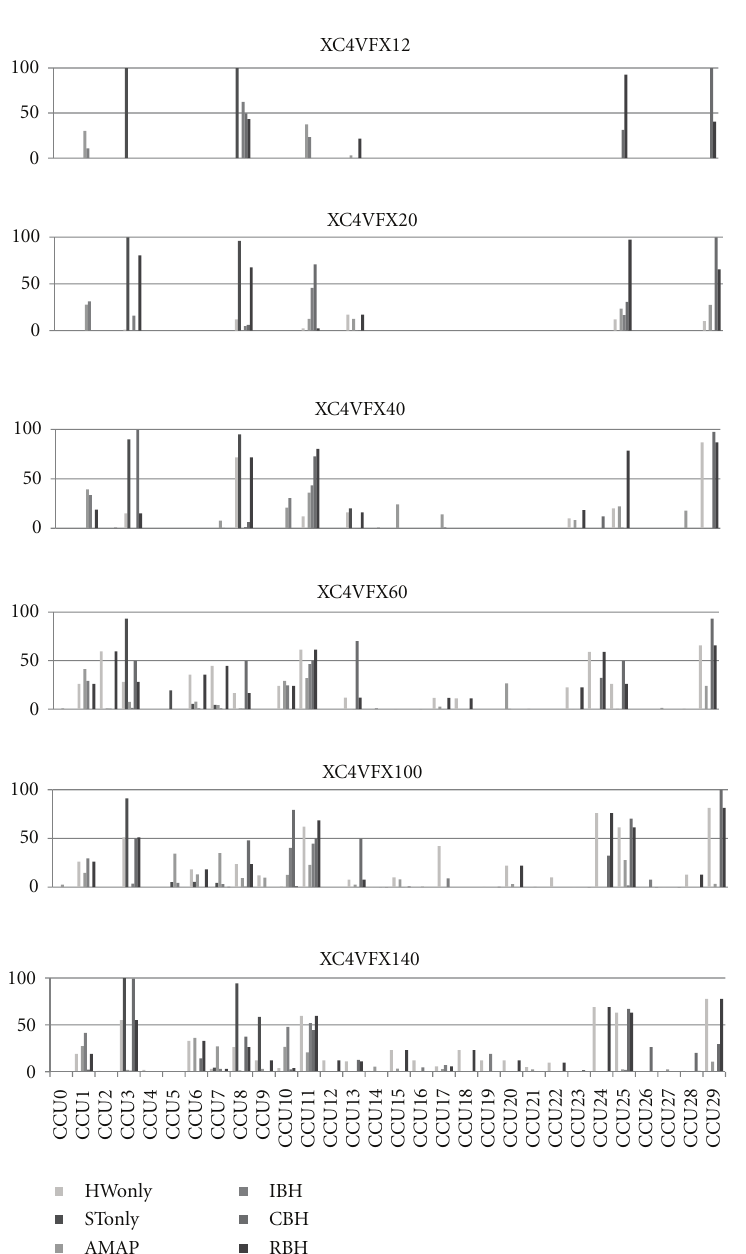
Figure 9: Reusability e ffi ciency (RE Task ) of CCUs for di ff erent heuristics under di ff erent FPGA conditions. The CCU reuse is significantly a ff ected by the number of area slices in the